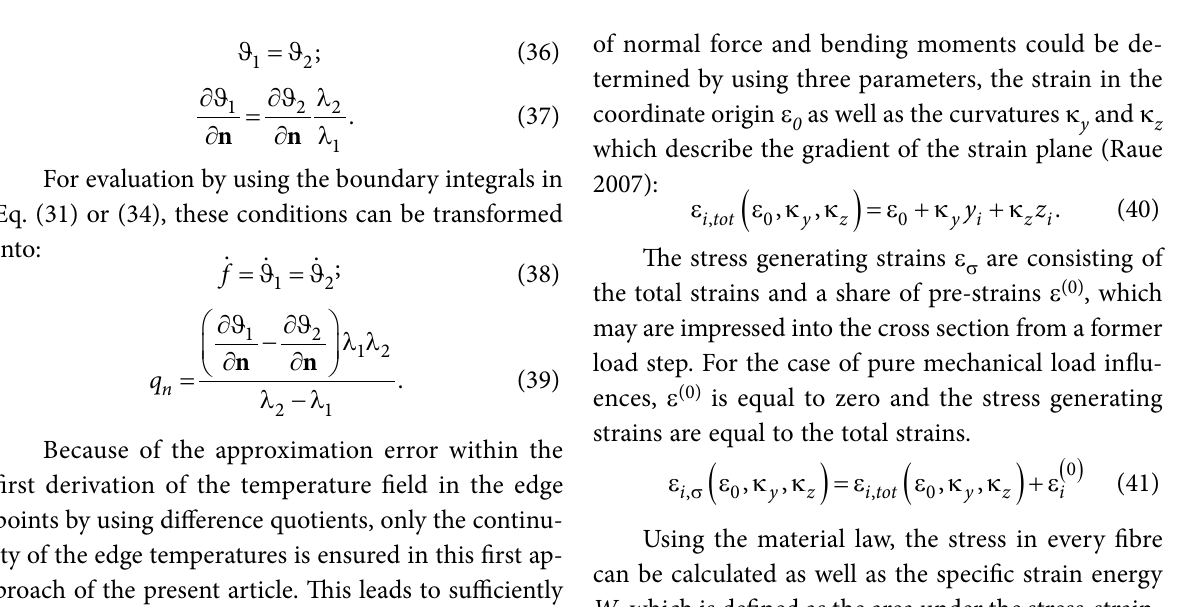
Fig. 3. Division of a composite T cross section into parts (left) and definition of the grid points inside of one part